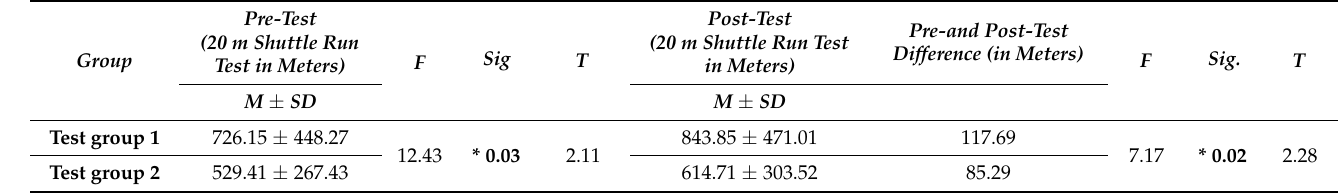
Table 2. Differences between the two test groups (pre- and post-intervention measurement).